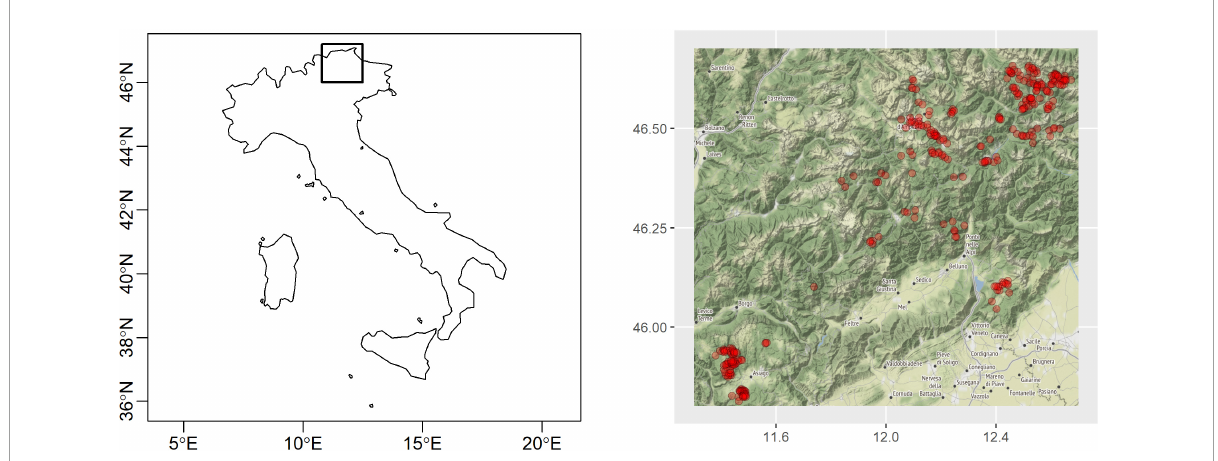
FIGURE1 The study was done in the forests of the Dolomites and Venetian Prealps, north-eastern Italy. The black square in the left panel marks the study area. Red points in the right panel are the centroids of the 331 management units (compartments) belonging to forest management plans that form the sample analyzed in this